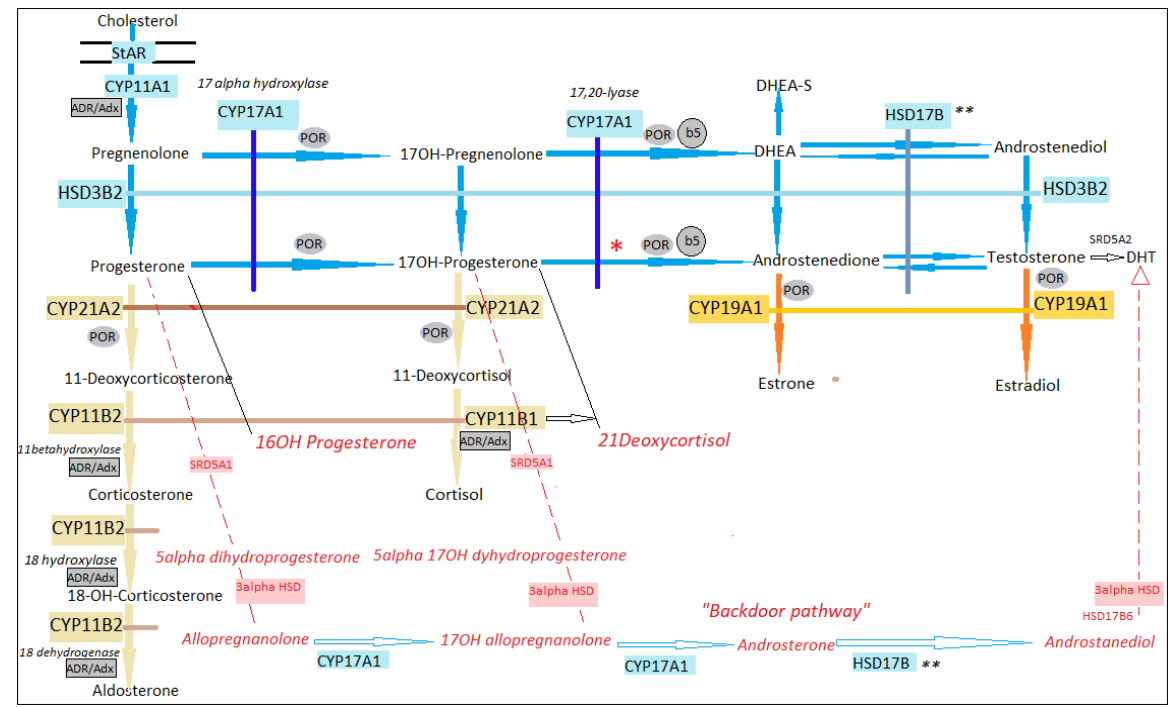
Figure 1. Adrenal and gonadal steroidogenic pathway. Blue area—common pathways for adrenals and gonads, cream area—observed only in the adrenal gland, orange area—observed only in the gonads, red zone—alternative pathway «backdoor pathway»; * under normal conditions 17hydroxyprogesterone is not a preferred substrate of 17 α hydroxylase; ** different types of 17 β HSD depending on the tissue in which it is expressed, testicle—17 β HSD3, adrenal cortex—